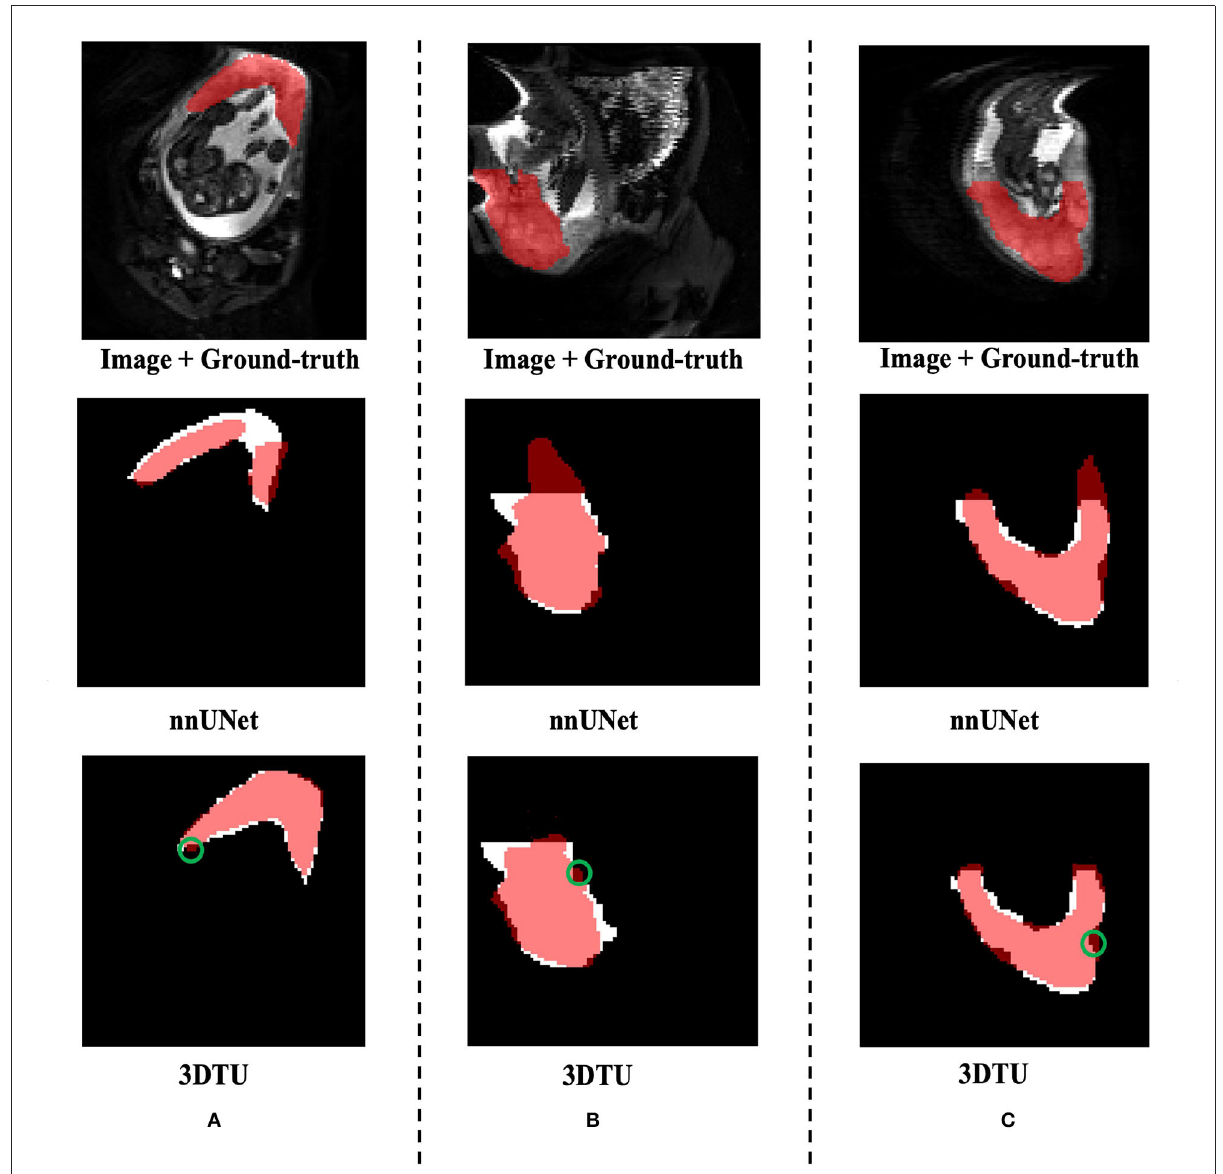
FIGURE3 Visualization of the segmentation results on the Placenta dataset produced by our 3DTU and nnUNet. Columns (A–C) show the x – y plane, y – z plane, and x – z plane of 3D segmentation predictions, respectively. The true-positive regions are highlighted in pink. The false-negative regions are highlighted in red (e.g., the green circle regions in the last row). Better view with colors and zooming